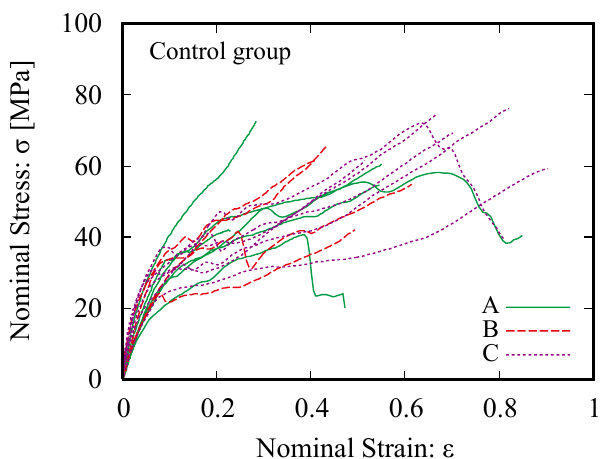
Fig. 11 Stress-strain diagrams of byssal threads in the control